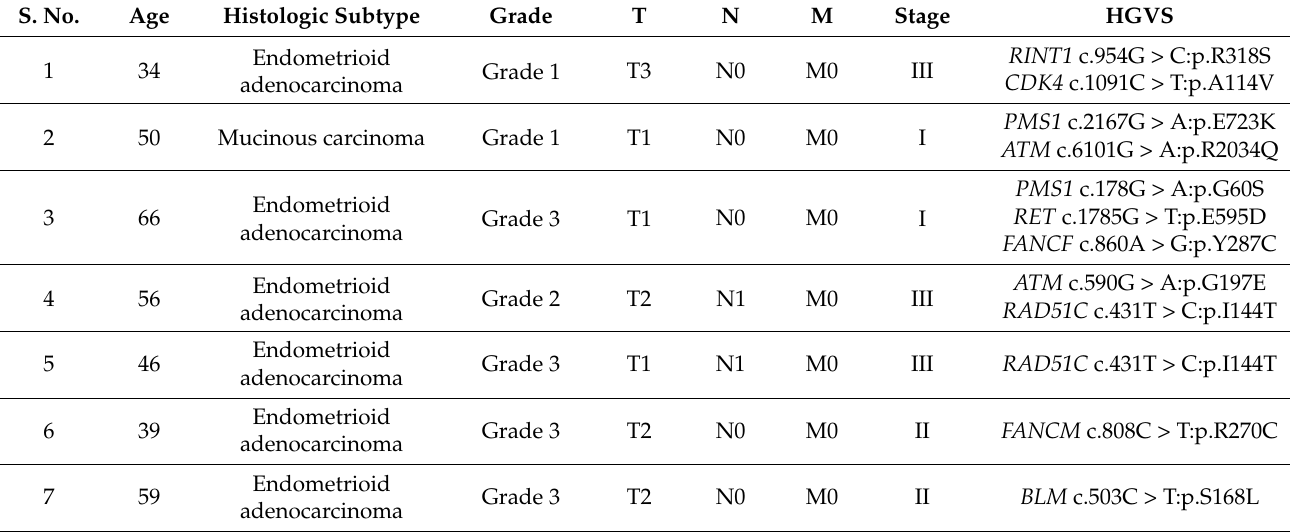
Table 4. Clinicopathological details of cases carrying variants of uncertain significance in cancer- related genes other than MMR